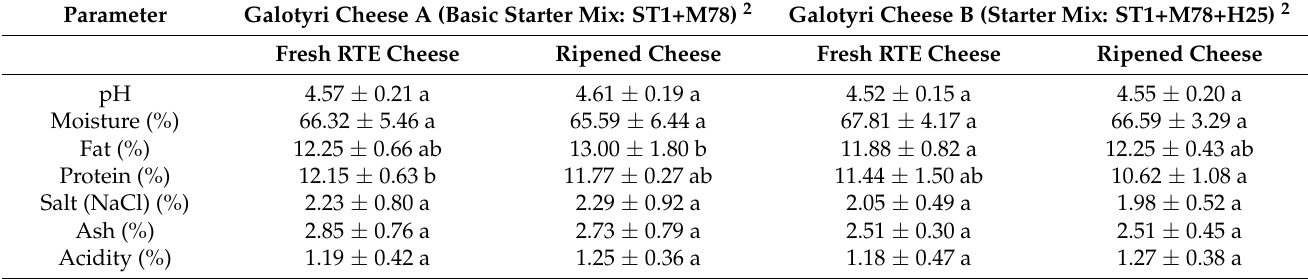
Table 3. Physicochemical characteristics of traditional Galotyri PDO cheese fermented with or without supplementation of the basic starter LAB culture with the adjunct strain L. plantarum H25 1